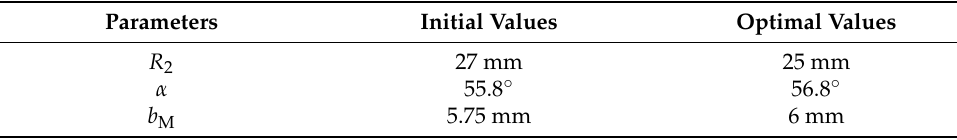
Table 5. The final main dimensions of the